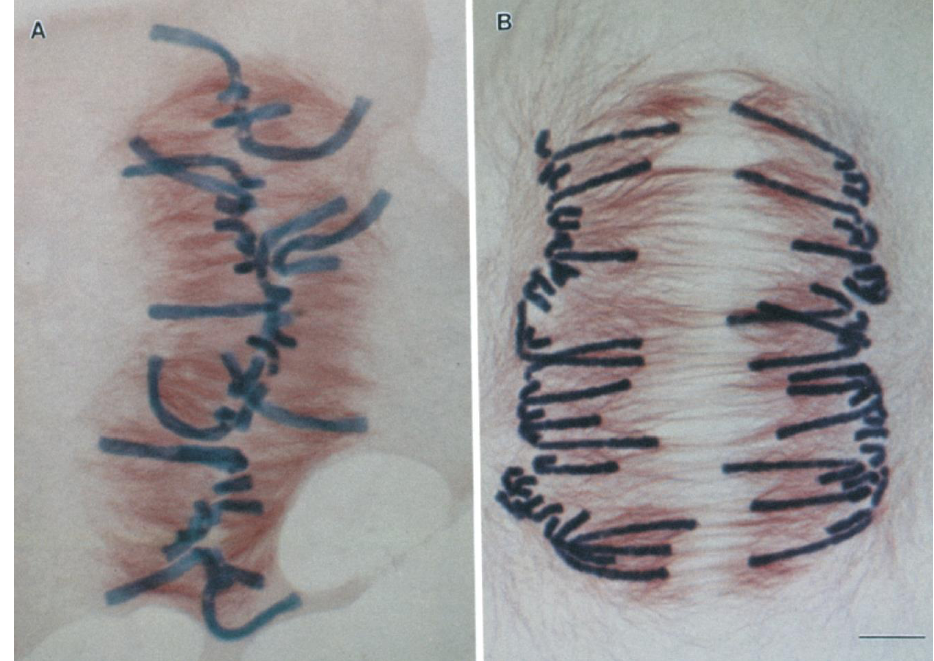
Figure 2. Light micrographs of metaphase ( a ) and late anaphase ( b ) plant endosperm ( Haemanthus ) spindles. During metaphase in these plant cells the chromosome arms are bent in the direction of the spindle poles. This behavior differs from what is seen in animal somatic cells, where chromosome arms are pushed continually away from spindle poles [11]. These Haemanthus images are reprinted from [9], and are displayed under the terms of a Creative Commons License (Attribution- Noncommerical-Share Alike 3.0 Unported license, as described at http://creativecommons.org/ licenses/by-nc-sa/3.0/). Scale bar, 10